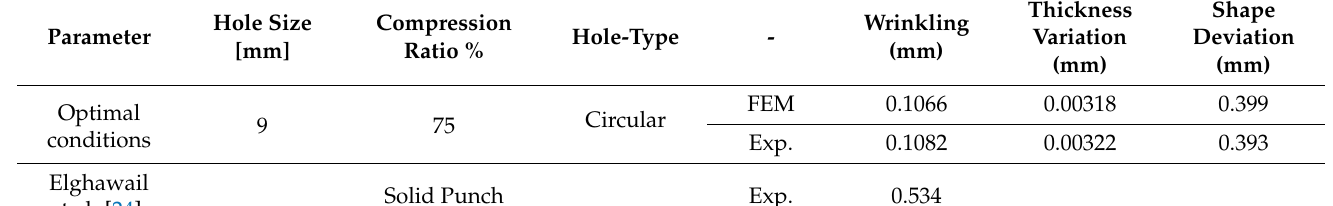
Table 5. Results at optimal process variables of the hole-type rubber punch.